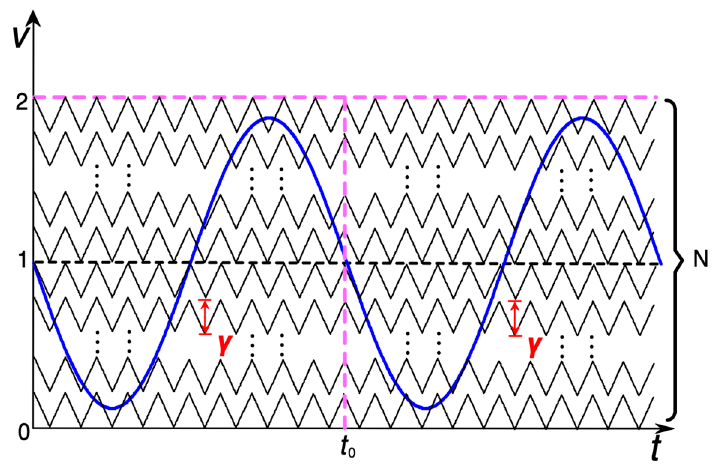
Figure 5. Modulation diagram of one phase under the normal operation.